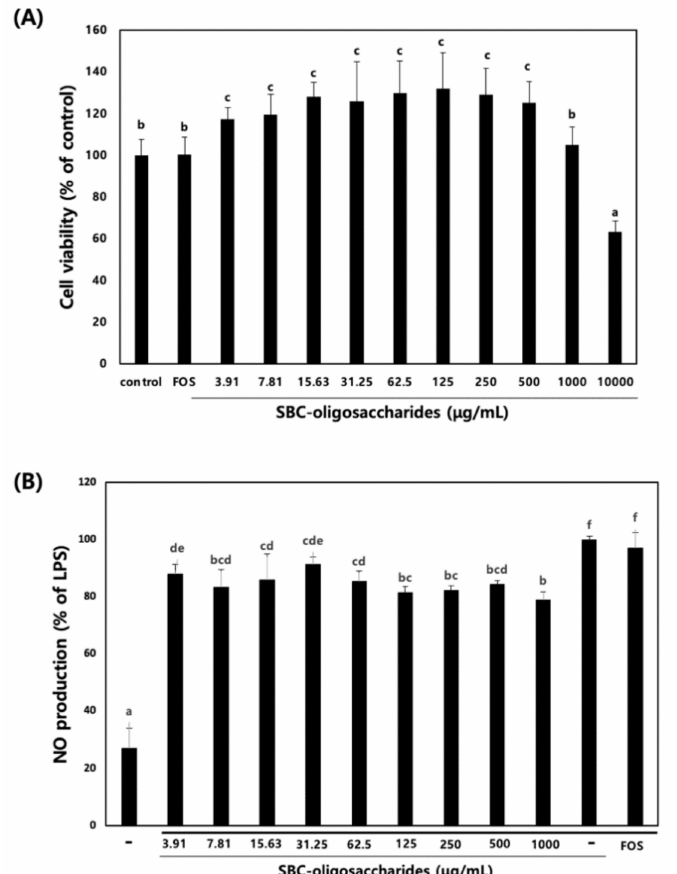
Figure 6. Effects of oligosaccharides on the cell viability and NO production in RAW 264.7 cells. ( A ) Effects of oligosaccharides on RAW 264.7 cell viability. ( B ) Effects of oligosaccharides on NO production in lipopolysaccharide (LPS)-stimulated RAW 264.7 cells. RAW 264.7 cells were treated with various concentrations of oligosaccharides for 1 h and then treated with 1 µ g/mL LPS for 24 h. NO production was evaluated using the Griess reaction assay. Different letters show significant differences among groups at p < 0.05 (n ≥